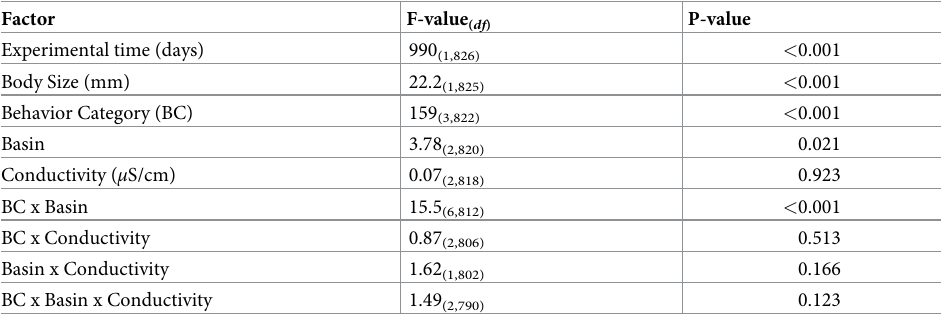
Table 2. Summary of results of ANOVA analyses with general linear model (GLMs) for total activity recorded from three caddisfly population (Choapa, Maipo and Maule) exposed to low (180 μ S/cm), medium (500 μ S/cm) and high (1400 μ S/cm) conductivity levels. Body mass and experimental time were used as covariates. Behavior cate- gories were used as a factor to test if the different behaviors (swimming, sheltering, walking and pushing-up) differed in proportion among experimental